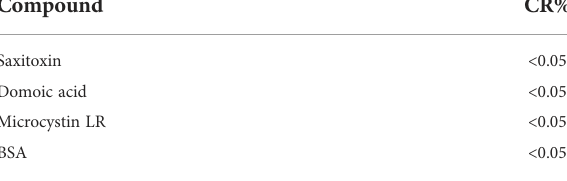
TABLE 1 Cross-reactivity (CR) with other marine toxins by